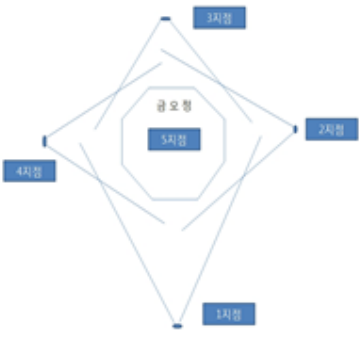
Figure 3. Five stations of Terrestrial LIDA